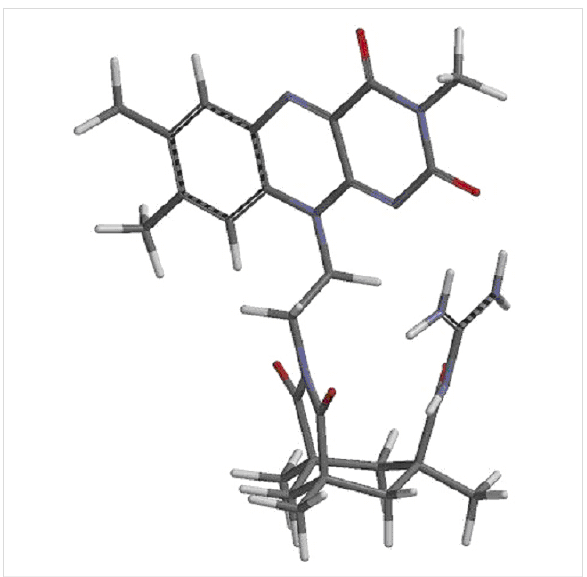
structures of 6 and 9 . The planar flavin chromophore is turned outward relative to the Kemp’s acid. Intermolecular π-π-interac- tions between the flavin heteroarenes are observed.